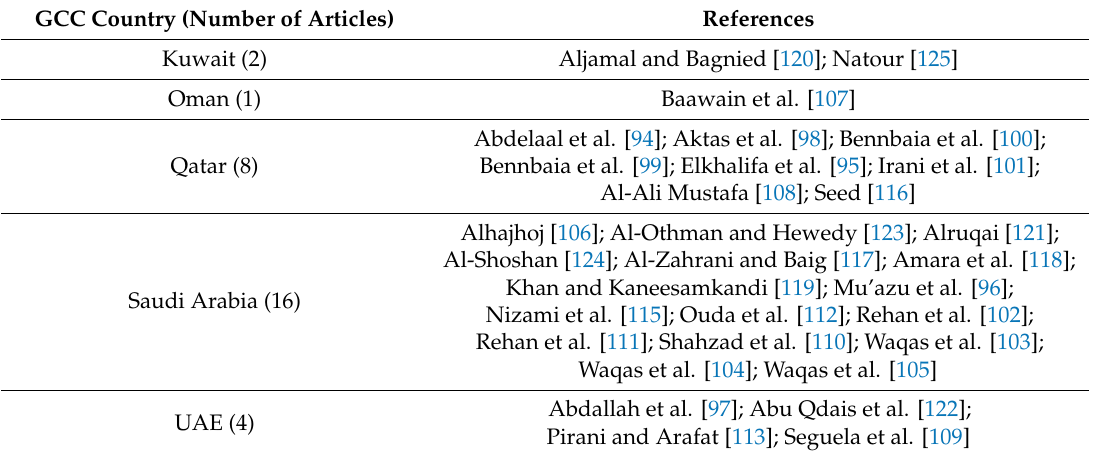
Table 3. GCC countries where research on food waste was performed.